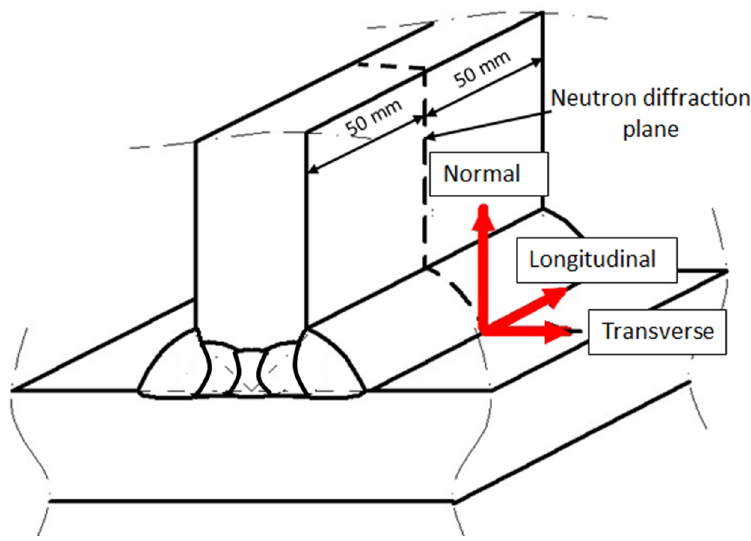
Figure 5. Welded specimen showing the three directions of stress measurements and the neutron diffraction plane.